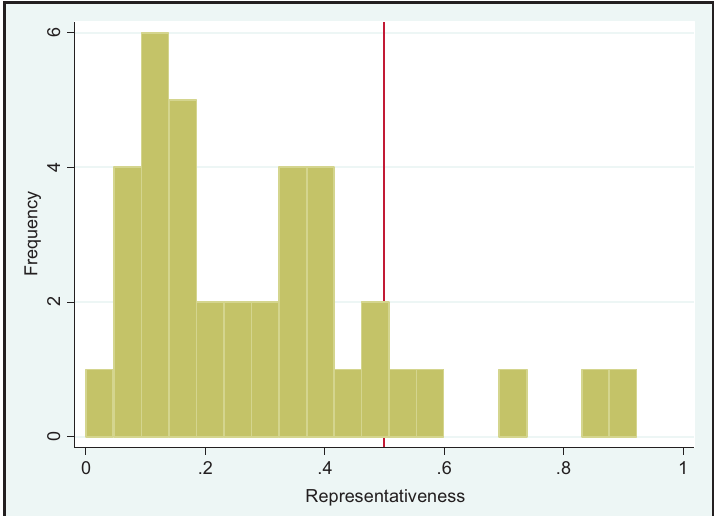
Figure 2 The representativeness of collective agreements.